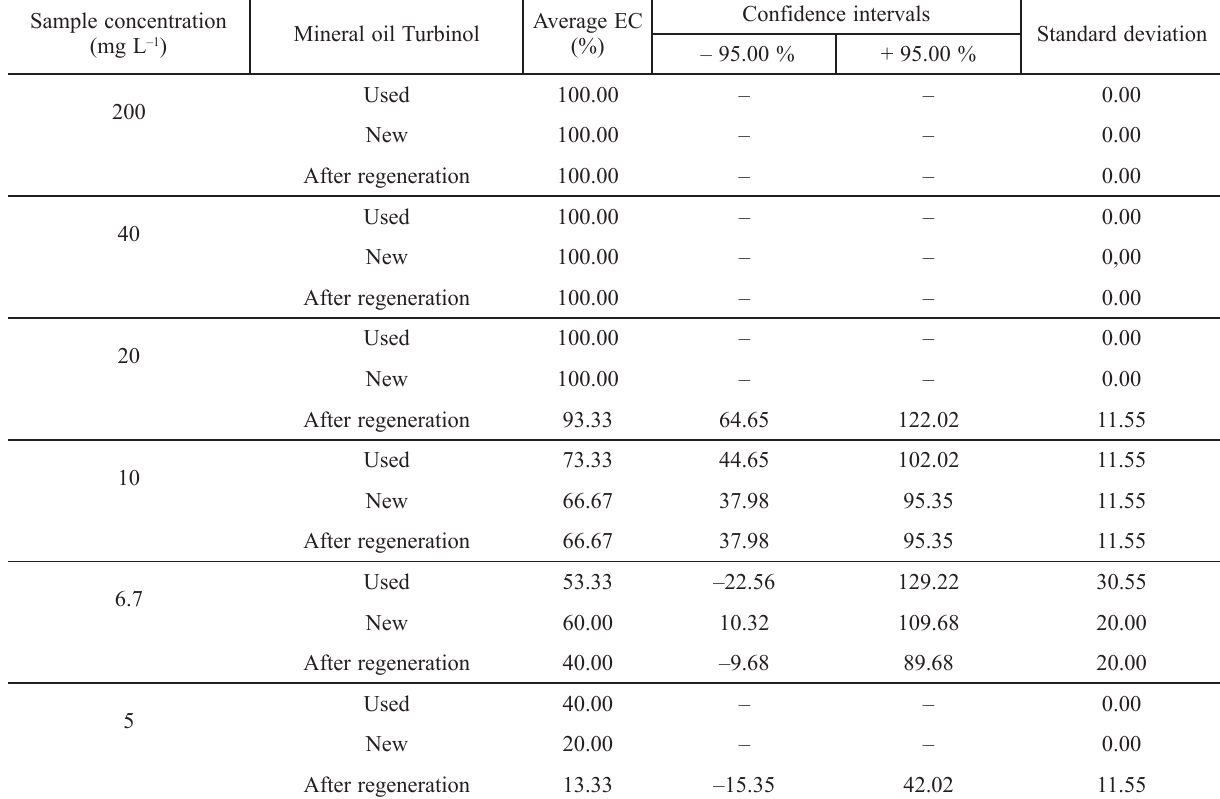
Table 4 – Basic statistical characteristics of acute toxicity test results of Daphnia magna Sample concentration (mg L –1